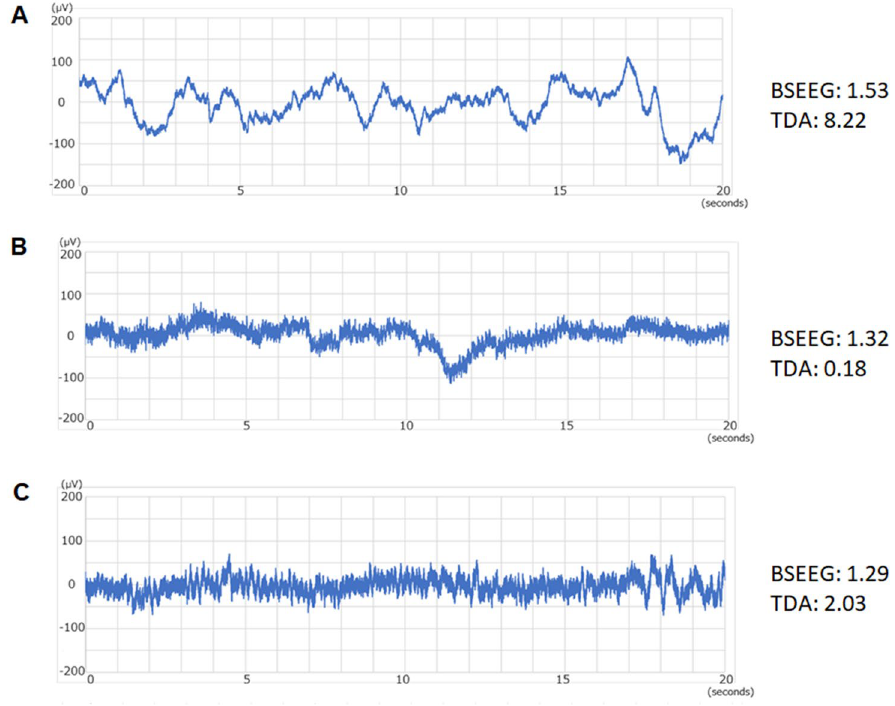
Figure 2. Examples of EEG signals in case of ( A ) obvious slowing where both BSEEG and TDA show positive scores, ( B ) obvious normal signals where both BSEEG and TDA show negative scores, and ( C ) not obvious slowing where BSEEG show negative scores, but TDA show positive scores.